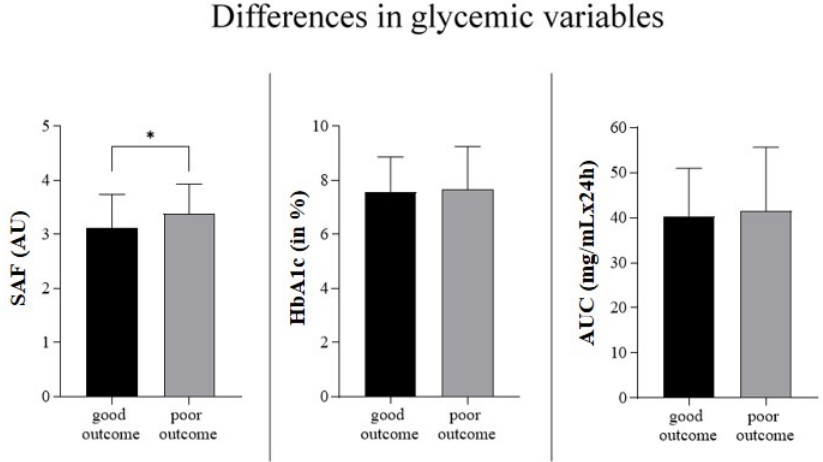
Figure 2. Differences in glycemic variables according to 90-day outcome: mean and standard deviation of SAF, HbA1c and AUC. * Significant difference, skin autofluorescence (SAF), area under the curve (AUC), arbitrary units (AU).